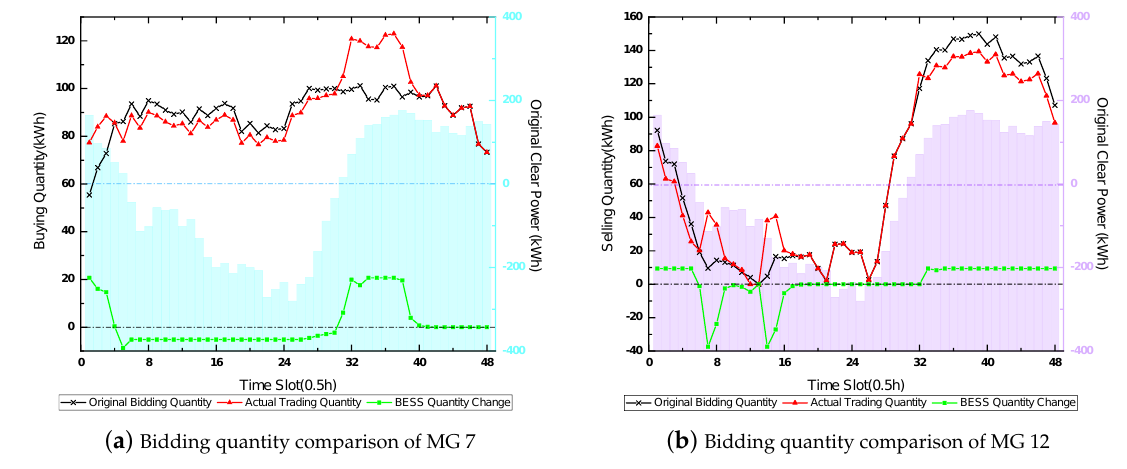
Figure 13. Bidding performance on quantity of MG 7 and MG